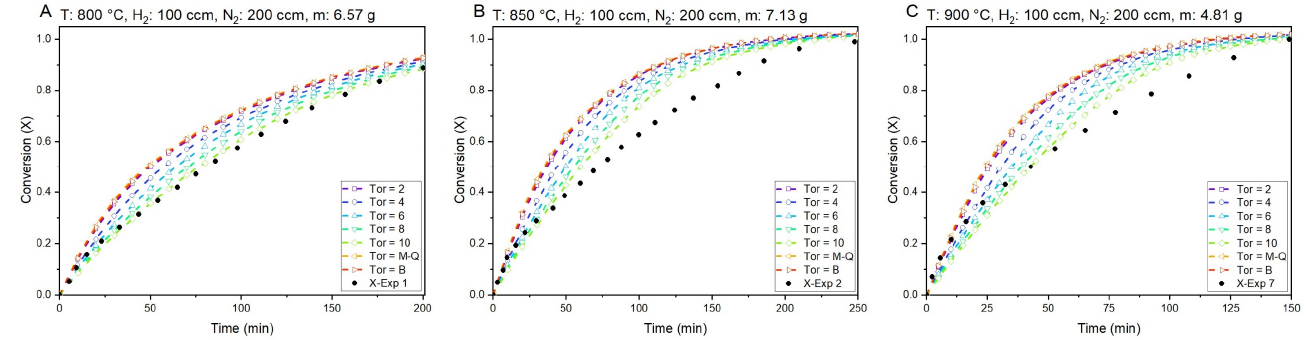
Figure 18. X vs. t curves obtained from the model for different values & functions of tortuosity for ( A ) Experiment 1, ( B ) Experiment 2 and ( C ) Experiment 7.